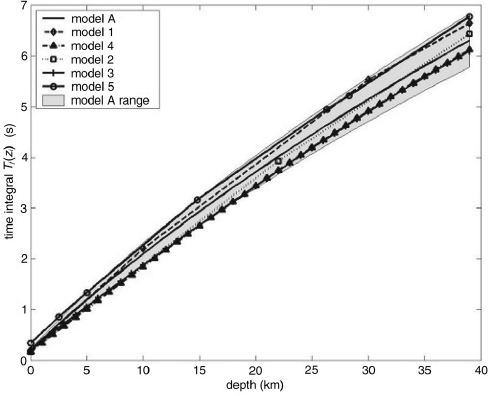
Fig. 11. Integral functions versus depth for the models shown in fig. 10. In grey the range of vari- ability of the integral function calculated for the 1D DSS/WARR model.